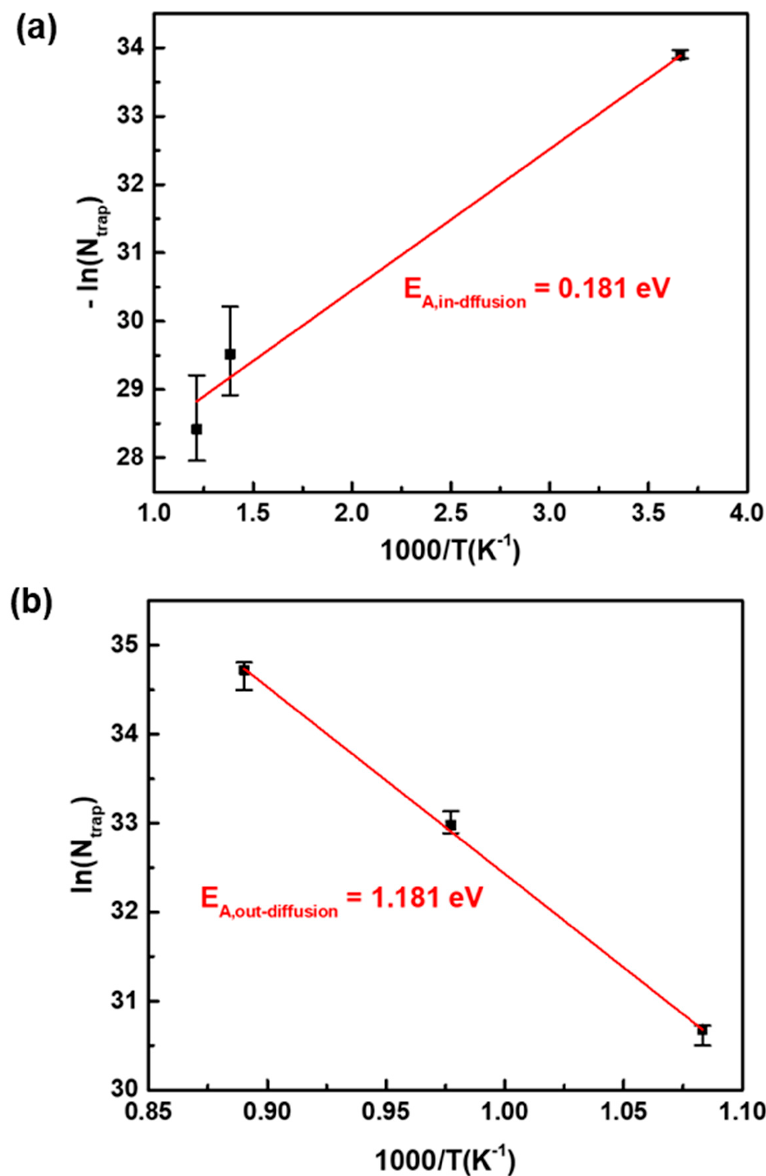
Figure 8. Calculated results of the ( a ) in-diffusion and ( b ) out-diffusion energy of hydrogen in the grain boundary area.